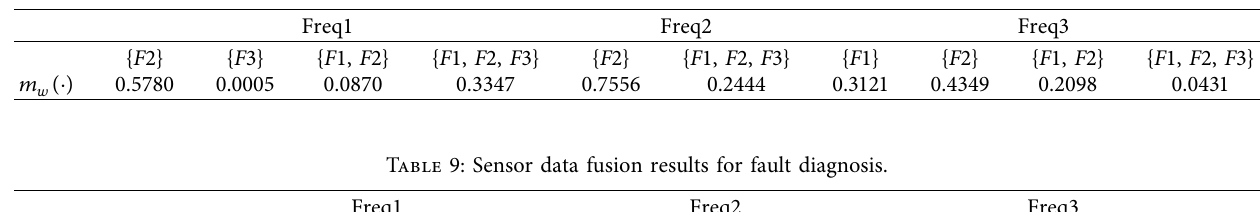
Table 8: Modified mass function.